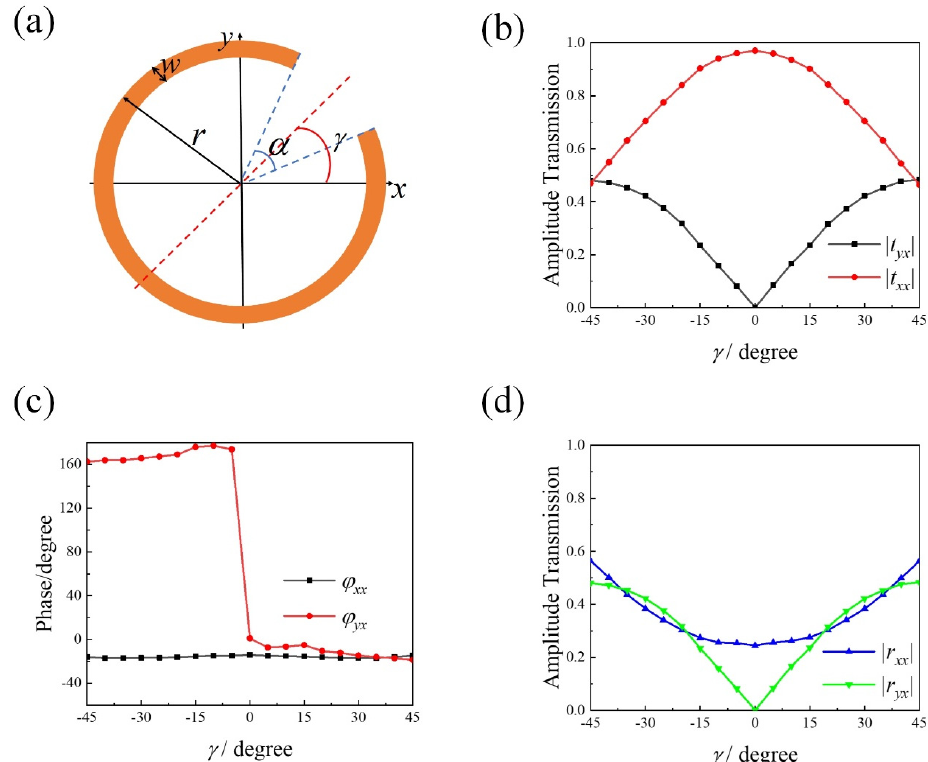
Figure 1. ( a ) Schematic of circular-shaped SRR with opening angle α , radius r , width w and rotation angle θ with respect to x -axis. ( b ) Simulated transmission amplitude and ( c ) phase of an array of circular-shape SRR with ( r , α , w ) = (34 µ m, 45 ◦ , 5 µ m) and γ varying from − 45 ◦ to 45 ◦ at 0.84 THz. ( d ) Simulated reflection amplitude. The period of the array is 80 µ m in both x - and y -direction.